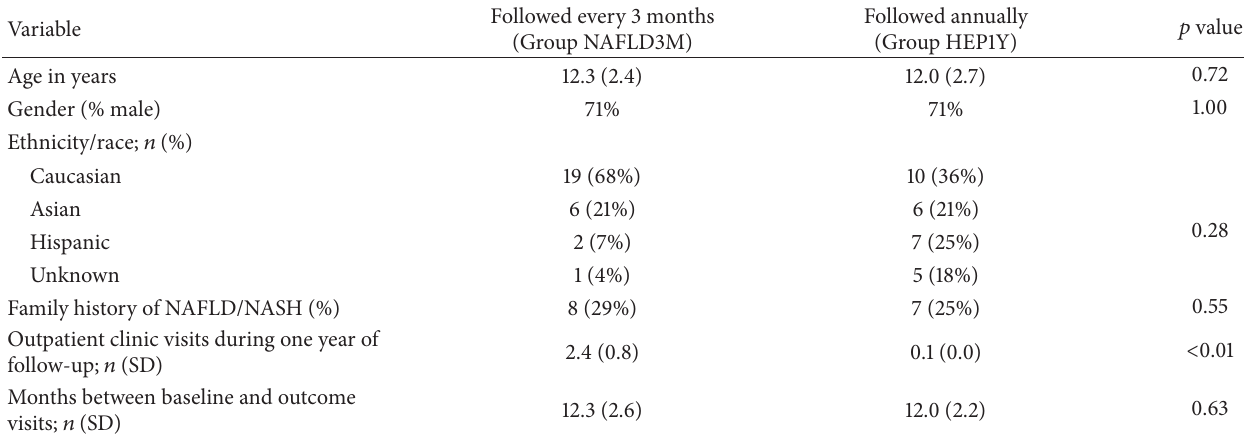
Table 1: Demographics and baseline patient